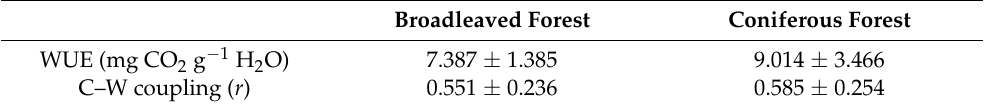
Table 2. The mean and standard deviation of WUE dt and diurnal C–W coupling (correlation coeffi- cient r between hourly GPP and ET) in the broadleaved forest at Dinghushan and in the coniferous forest at Qianyanzhou on summer no-rain days over 2003–2005. The form of values in the table is mean ± standard